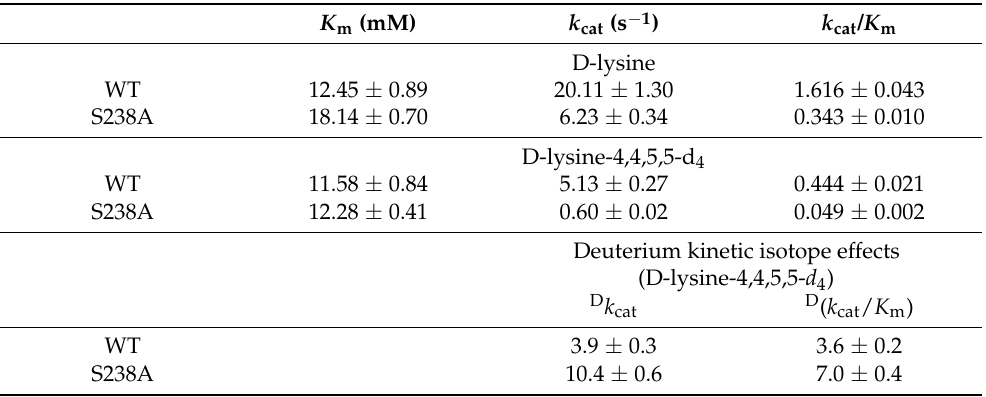
Table 1. Comparison of kinetic parameters of WT and S238A variant and deuterium kinetic isotope effects upon reaction with D-lysine-4,4,5,5-d 4 .